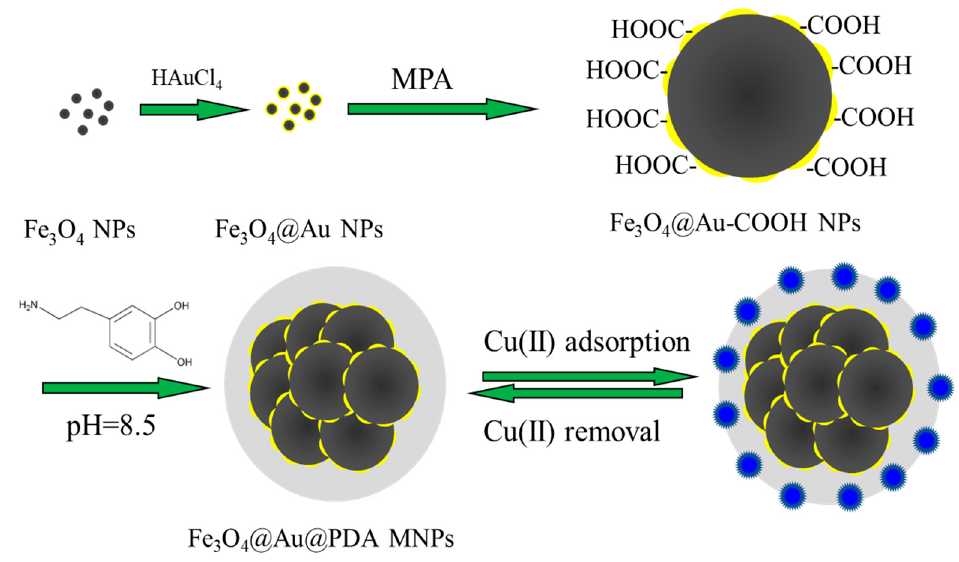
Figure 1. Synthesis route of magnetic nanocomposites.